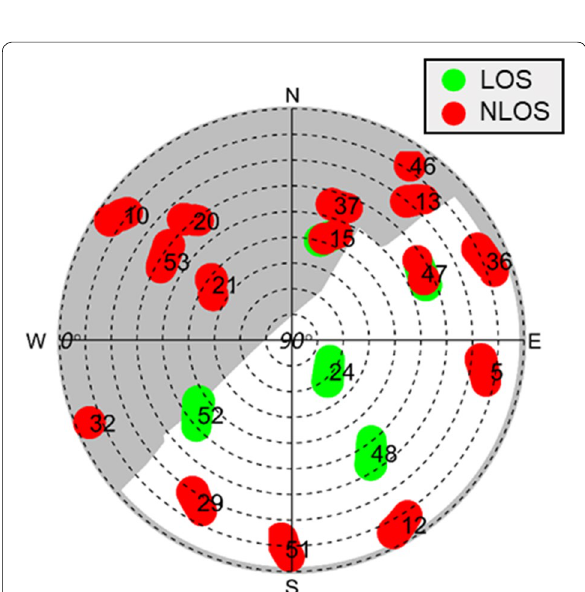
Fig. 10 Skyplot of P6 with the satellite visibilities determined by SVM